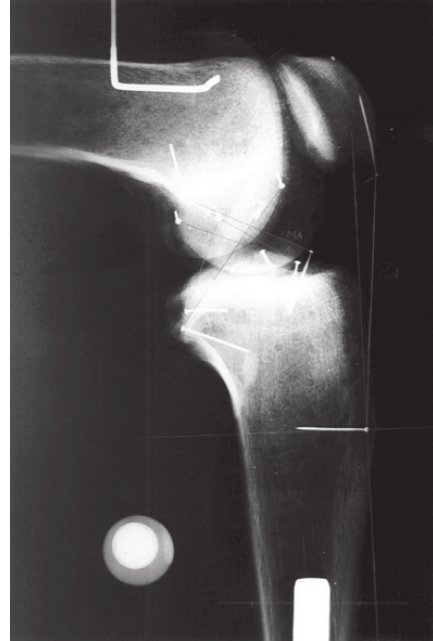
Figure 1 - Radiograph of a lateral view of the knee in 90° flexion (specimen no. 16). Note the metallic pins on the femoral and tibial cruciate ligament attachment sites and metallic pin on the tibial protuberance used as a reference for the tibial anatomical axis.